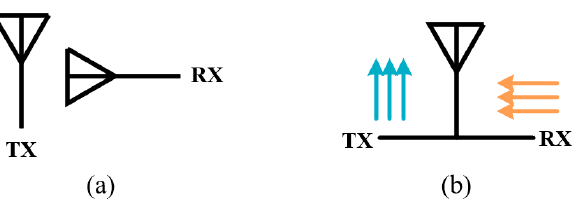
Figure 6. Polarization orthogonality realizations in ( a ) multi ‐ antenna system and ( b ) single/shared antenna system.